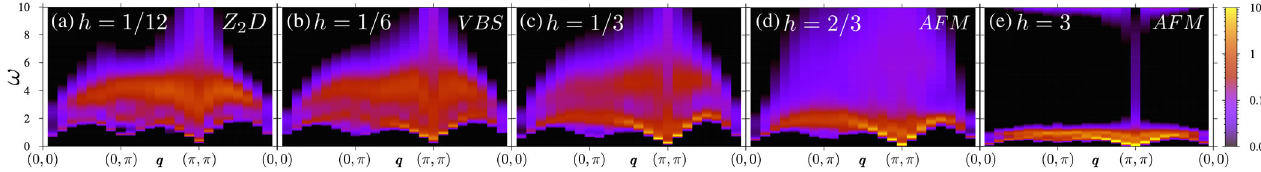
FIG. 19. Dynamical spin structure factor for the SU(3) model. The simulations were carried out on a 16 × 16 lattice at β ¼ 30 for h ≥ 1 = 6 and at β ¼ 60 for h ¼ 1 = 12